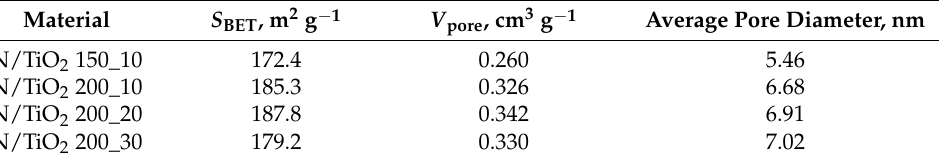
Table 2. Specific surface area, pore-volume, and crystallite size of N/TiO 2 materials. Material